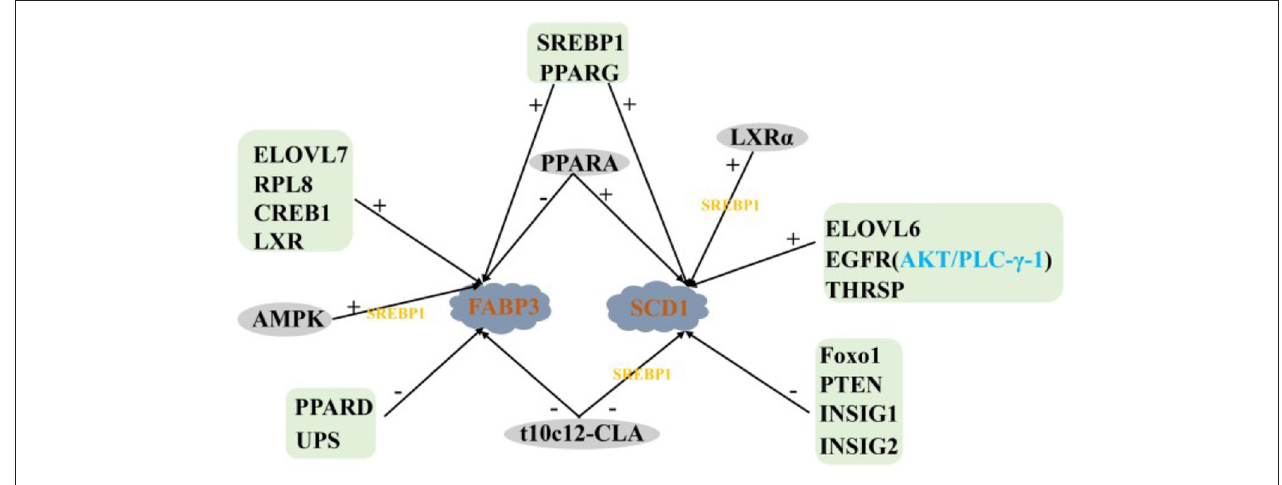
FIGURE 4 | Regulatory network of LCFA transport and desaturation in milk fat synthesis of ruminants. + : Positive regulation; –: Negative